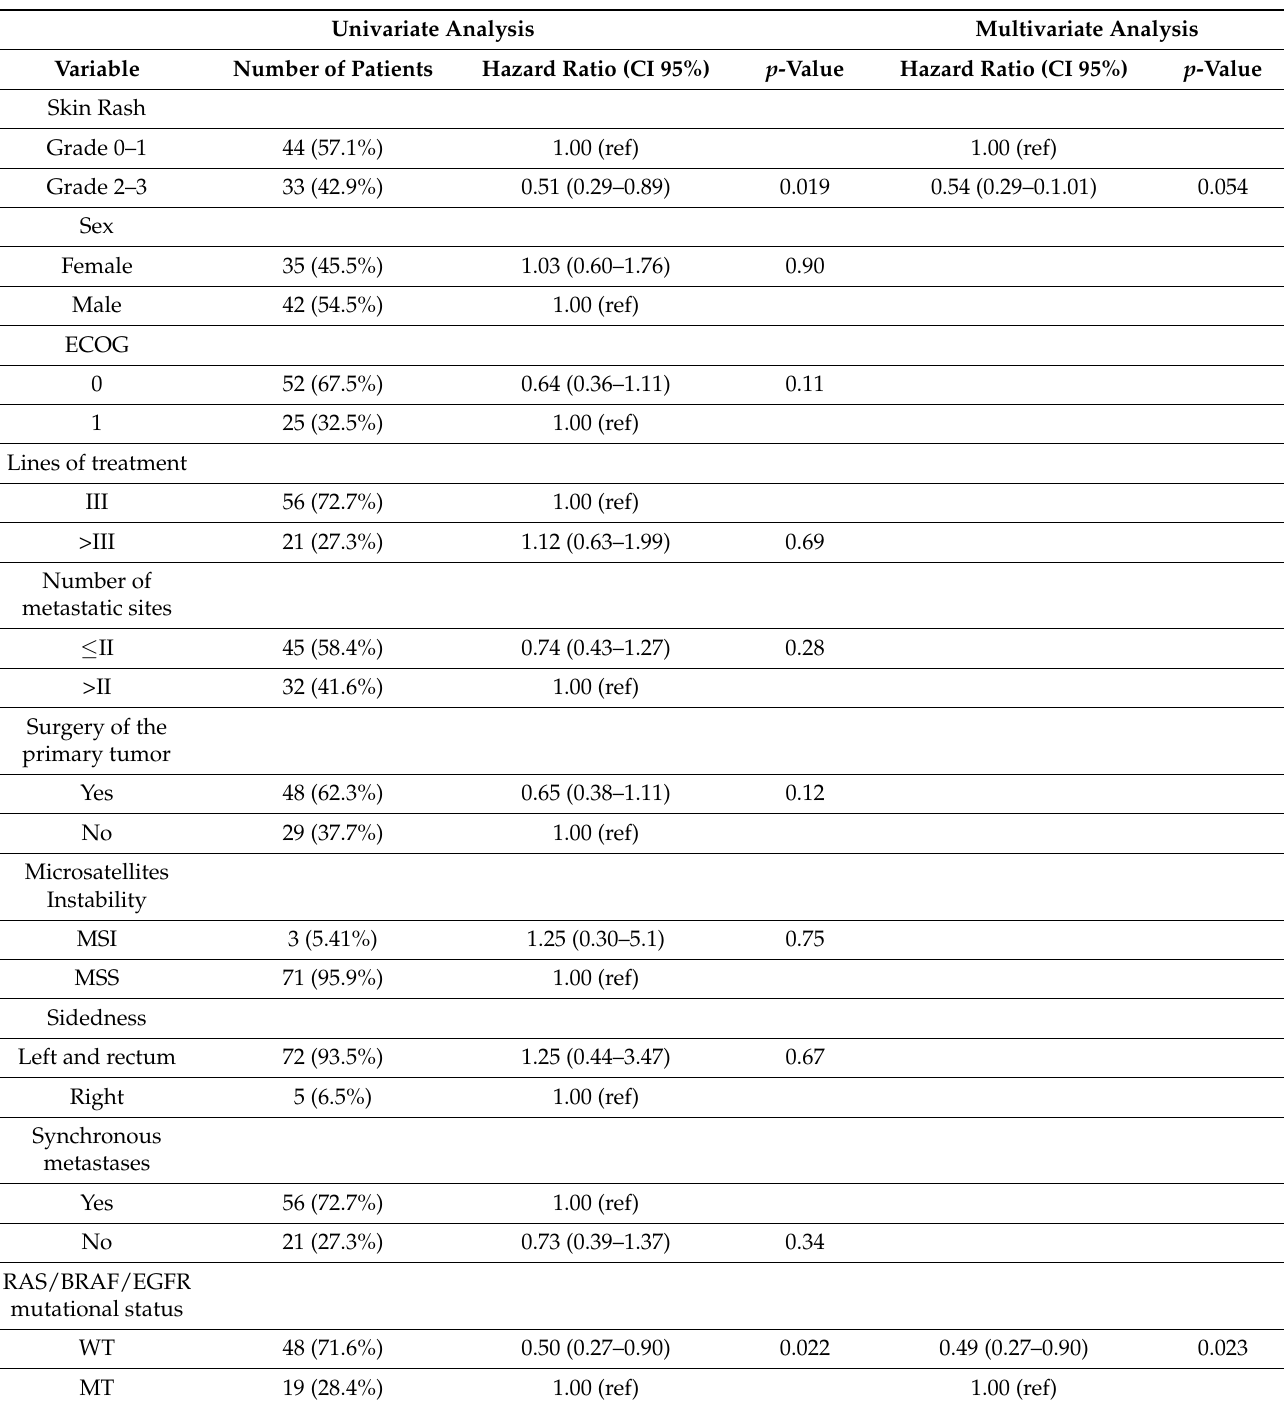
Table 2. Association of clinical variables with median overall survival by univariate and multivariate analysis. Univariate